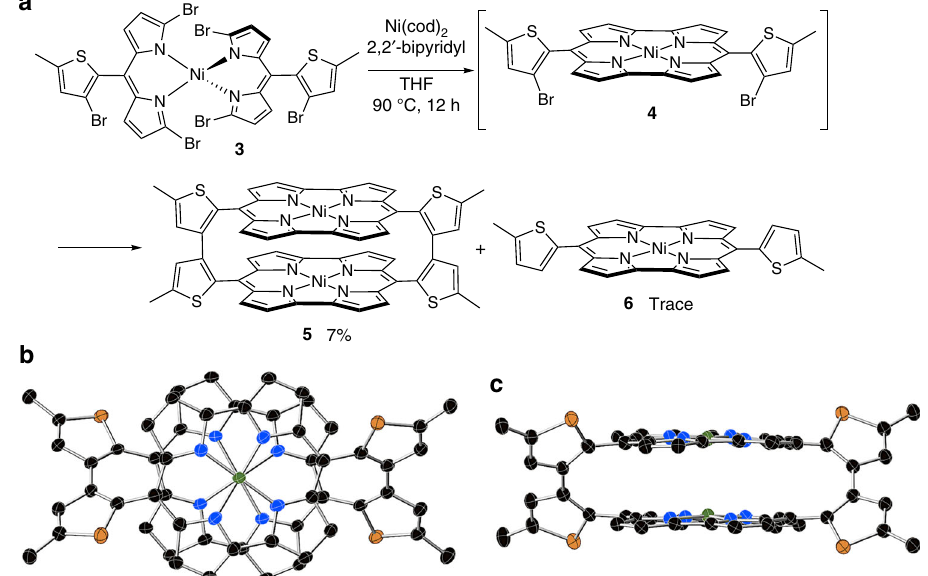
Fig. 3 Synthesis and structure of 5 . a One-pot synthesis of 5 from 3 . b , c Top and side views of the X-ray diffraction structure of 5 (hydrogen atoms are omitted for clarity; thermal ellipsoids are shown at 50%